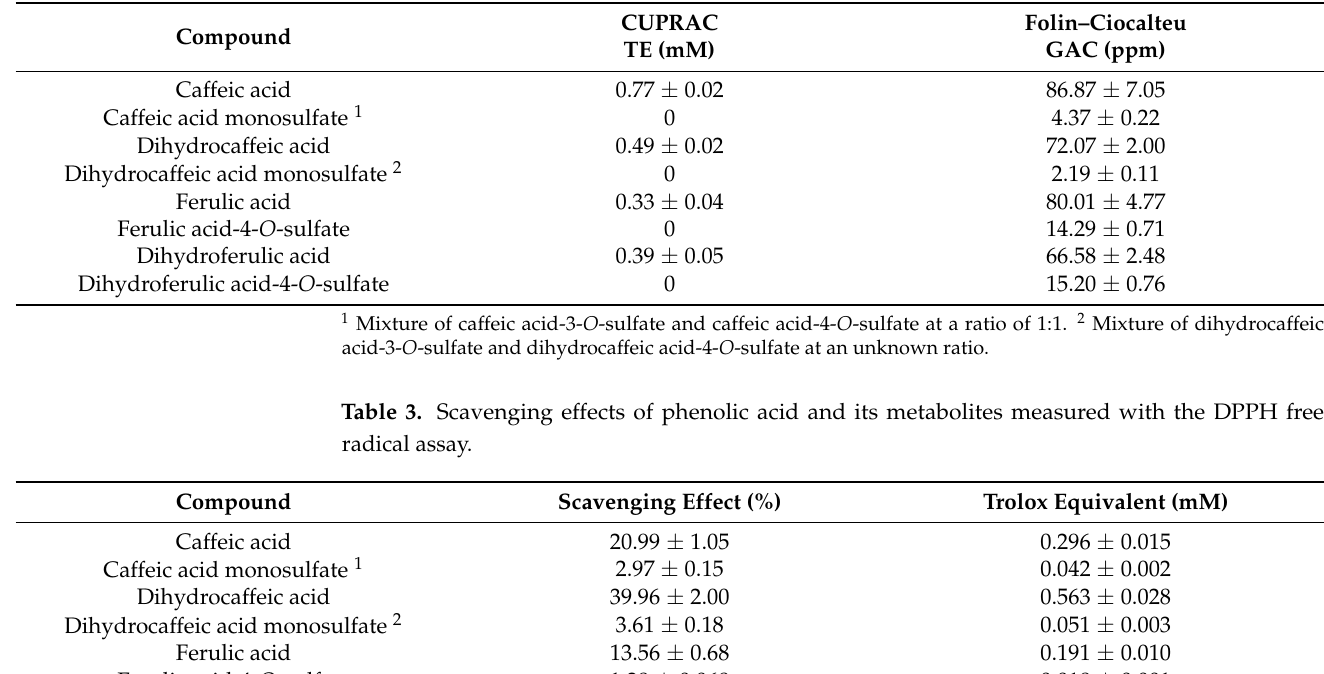
Table 2. Antioxidant capacities of phenolic acids and their sulfate metabolites measured with the CUPRAC (calculated as Trolox equivalent mM) and Folin–Ciocalteu (calculated as gallic acid equivalent ppm) assays.